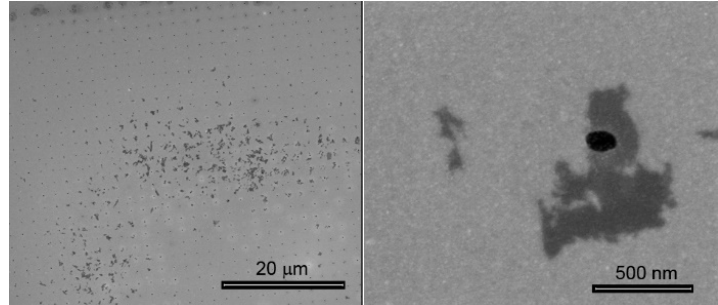
Figure 1. EPD of WS 2 suspended in H 2 O.